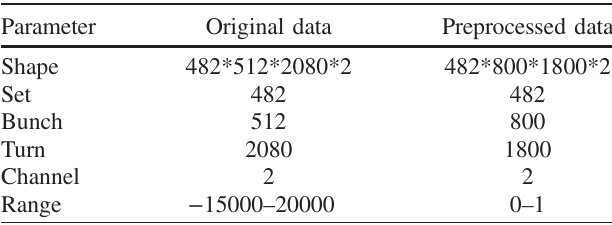
TABLE I. Dataset for CNN.